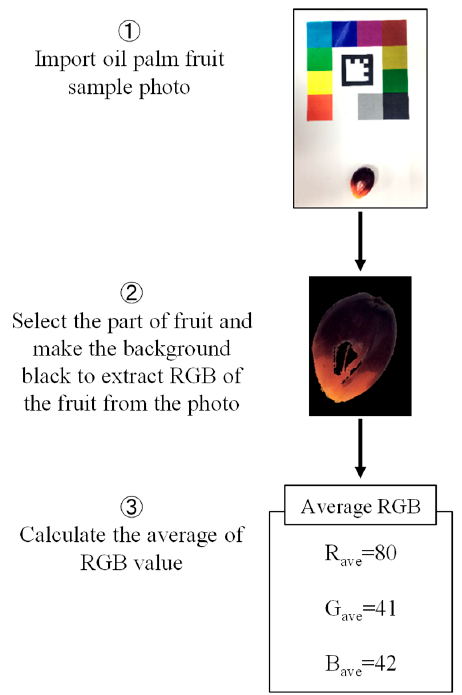
Figure 5. The flowchart of extracting color feature procedure.